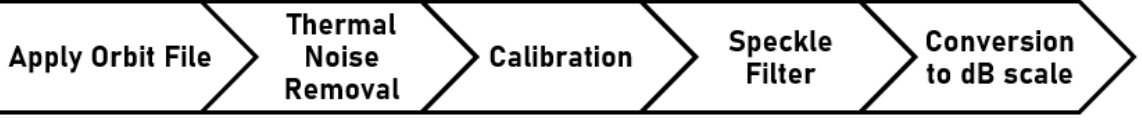
Figure 3. Pre ‐ processing chain for Sentinel ‐ 1 data performed in